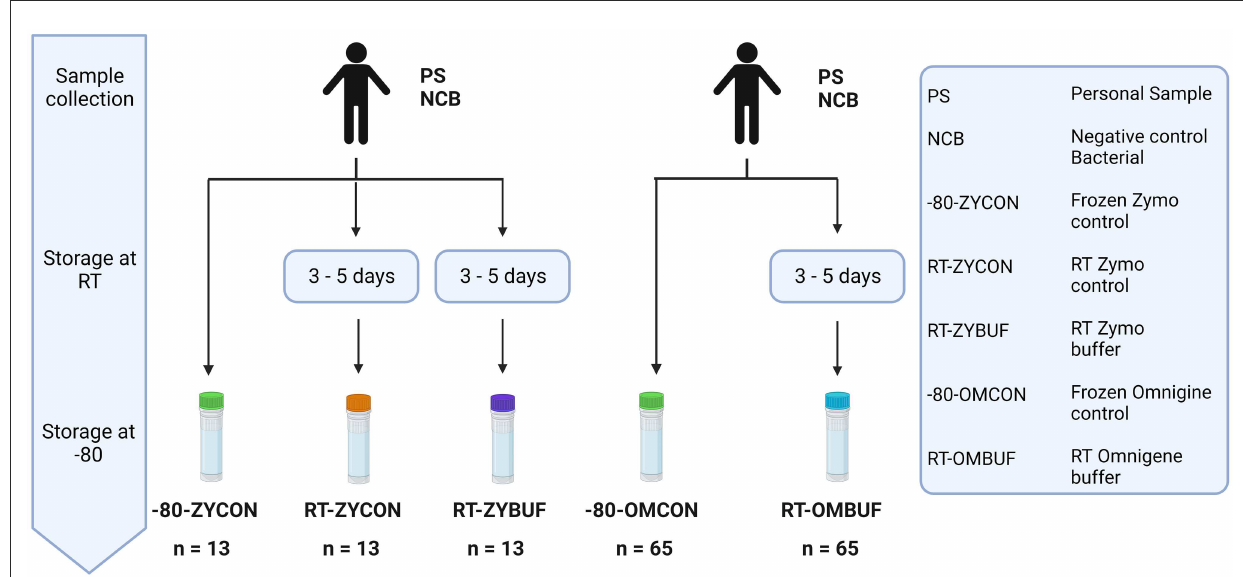
FIGURE2 Overview of the different methods for sample collection and storage. The effect of storage at RT for 3–5 days was tested with and without stabilization buffer of the Zymo research (ZYBUF) and OMNIgene · GUT (OMBUF) collection tubes and compared to the standard storage condition ( − 80). Three aliquots of fecal material from 12 participant samples (PSs) and one negative bacterial control (NCB) were tested: one control sample stored under standard storage conditions ( − 80-ZYCON) and two additional copies stored at room temperature for 3–5 days prior to freezing at − 80 ◦ C, with and without the Zymo Research stabilization buffer (named RT-ZYBUF and RT-ZYCON, respectively). In addition, fecal samples of 64 participants (PS) and one negative bacterial control (NCB) were analyzed under two conditions. In addition to the control sample collected under standard conditions ( − 80-OMCON), an additional aliquot was collected in the OMNIgene · GUT tube with a stabilization buffer and stored at RT for 3–5 days before freezing at − 80 ◦ C